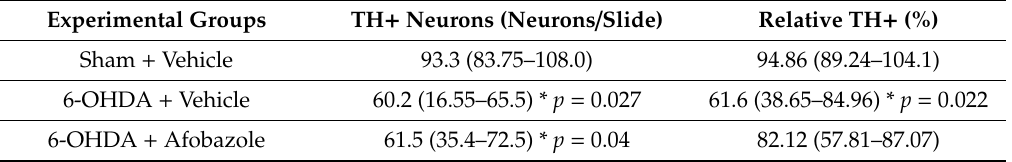
Table 1. The influence of afobazole on the tyrosine hydroxylase-positive (TH + ) cell count. Experimental Groups TH + Neurons (Neurons / Slide) Relative TH + (%) Sham +